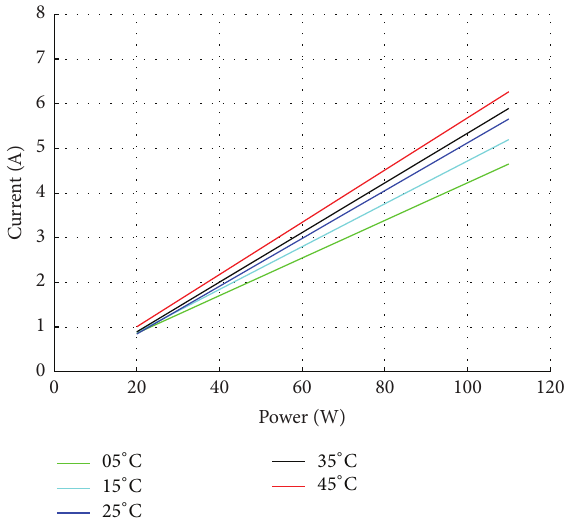
Figure 12: Lines of MPP for different temperatures ( ∘